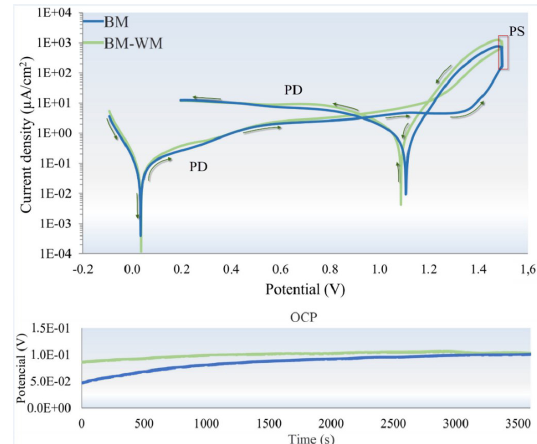
Figure 8. Crevice corrosion tests curves in BM and BM-WM in NaCl 3.5% solution (20 ± 2 °C), and their corresponding OCP. ), breakdown potential ( E ), passivation current density R bd